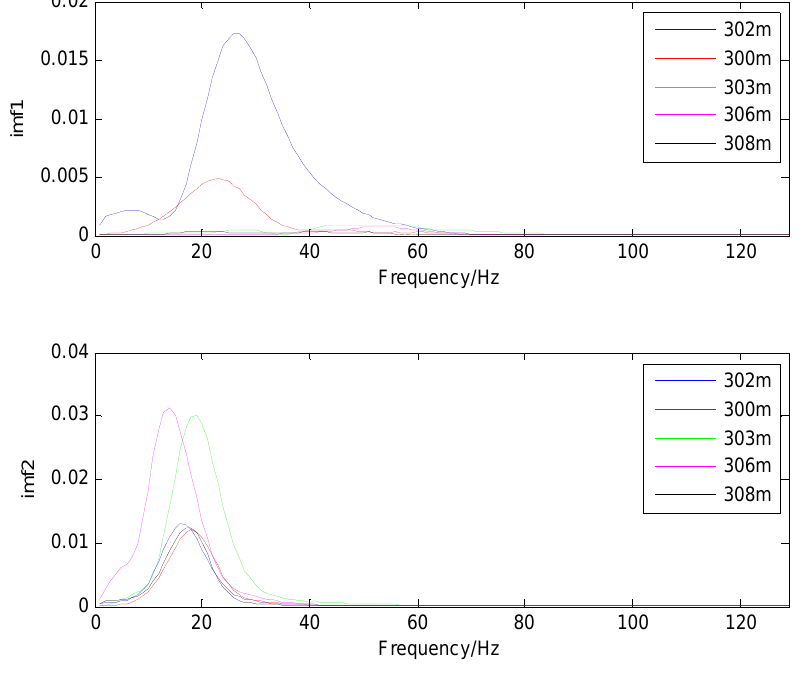
Figure 18. Power spectra of IMF 1 and IMF 2 from different ECG